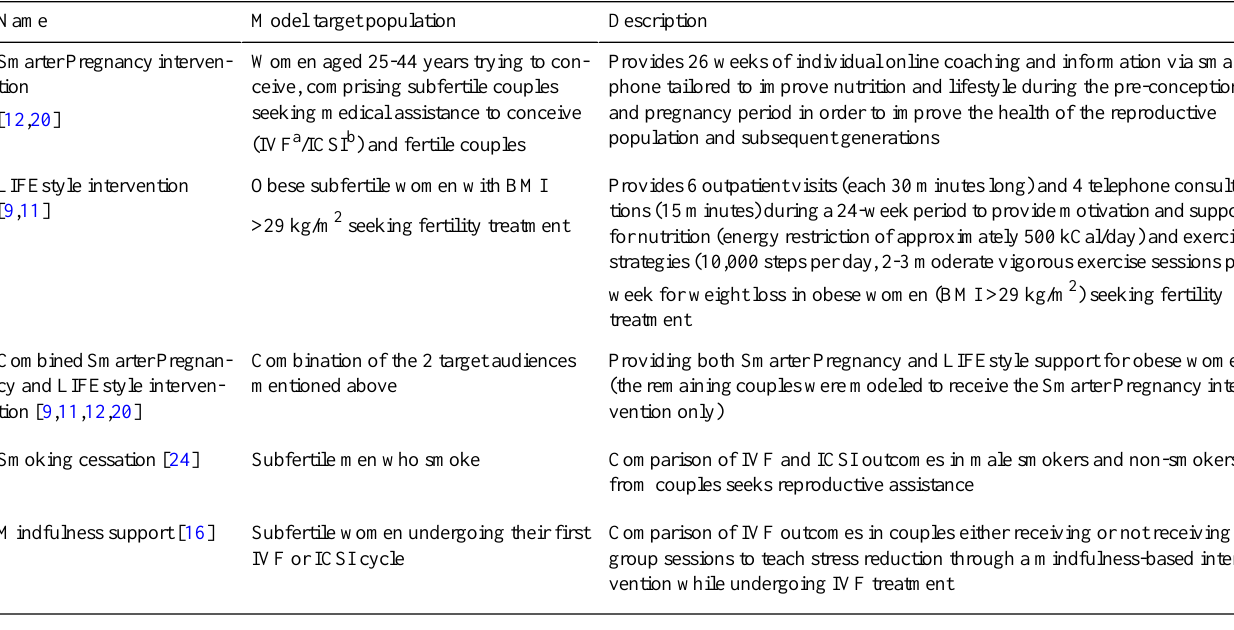
Table 1. Lifestyle interventions selected for cost-effectiveness